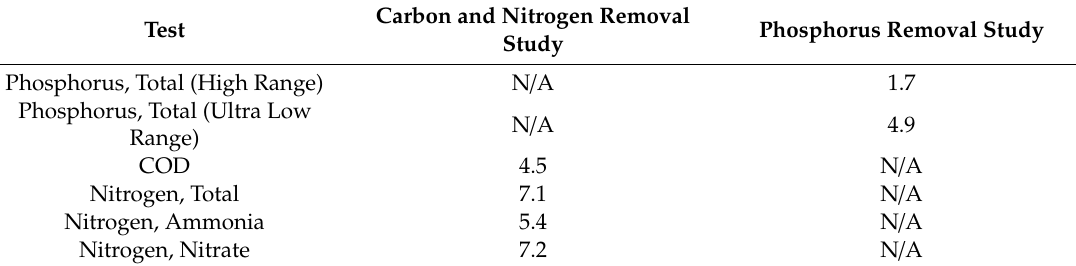
Table 6. Percent relative range.